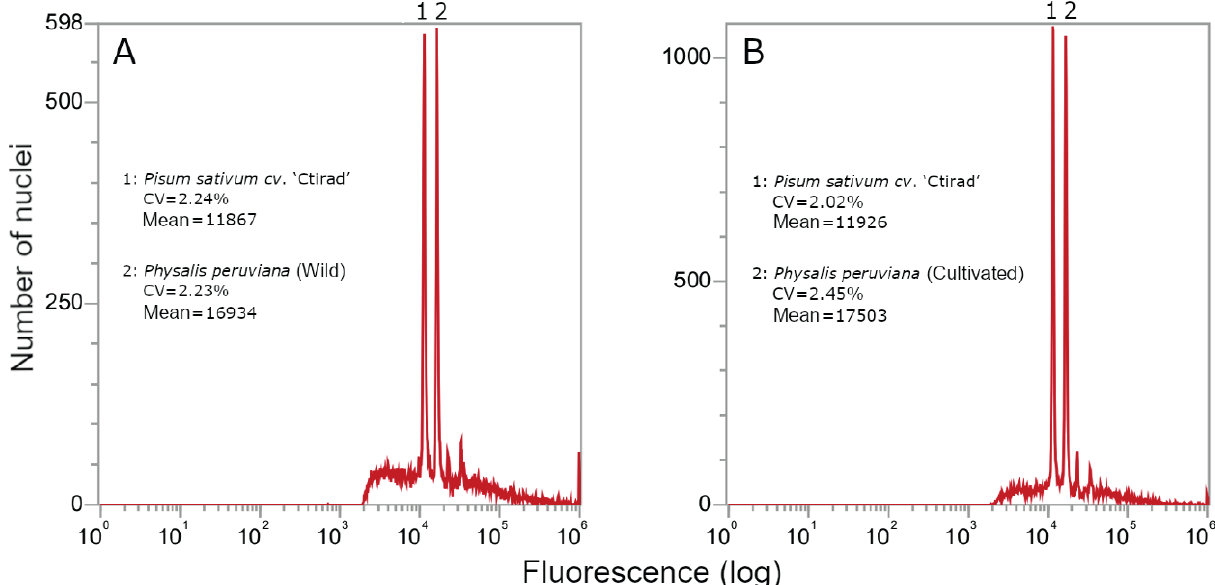
Figure 7 Fluorescence histograms of the nuclei of goldenberry and Pisum sativum cv . Ctirad populations (2C = 9.06 pg as internal reference standard) were analyzed simultaneously. Each peak denoted by the numbers 1 or 2 corresponds to the populations of nuclei in the G0/G1 phase of each species. Each histogram includes the percentage of the coefficient of variation (CV) and average absolute fluorescence for each of these